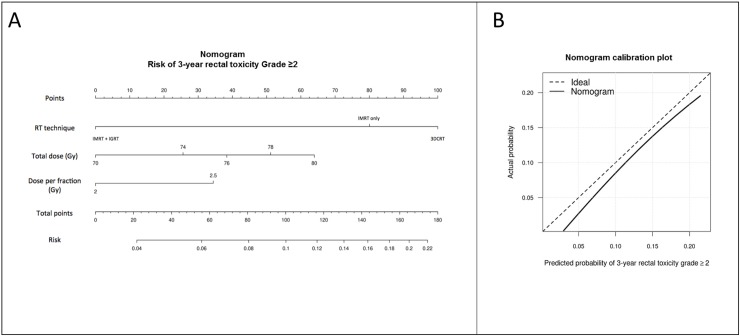
Nomogram and calibration plot (validation cohort) for the 3-year Grade ≥2 overall late rectal toxicity risk.3DCRT: 3D conformal radiotherapy, IGRT: image-guided radiotherapy, IMRT: intensity-modulated radiotherapy. To use the nomogram, align a straight edge so that it intersects with each predictor line (RT technique, total dose, or dose per fraction), then read the corresponding "Points" on the first line for each predictor. Add the points of the three predictors in order to calculate the total points. Align your straight edge to the "Total points" line and read the toxicity "Risk" on the last line. For example, a patient treated with IMRT and IGRT (0 points) to a total dose of 80 Gy (65 points) at 2 Gy (0 points) per fraction has a risk of late rectal toxicity of 7% (65 points). Calibration plot to assess the nomogram performance by a nonparametric fit of the predicted probability versus actual observed probability in the validation cohort. The corresponding C-index is 60%.